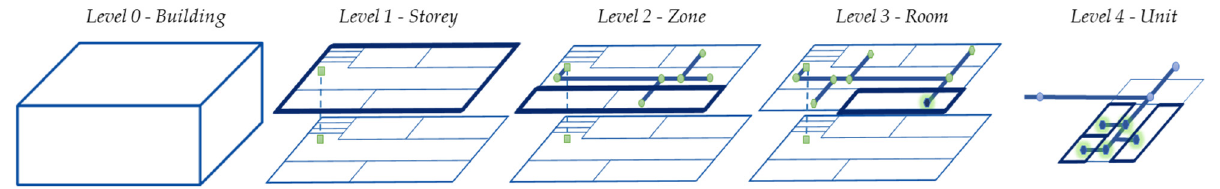
Figure 5. Levels of detail for representing indoor navigation networks [55].